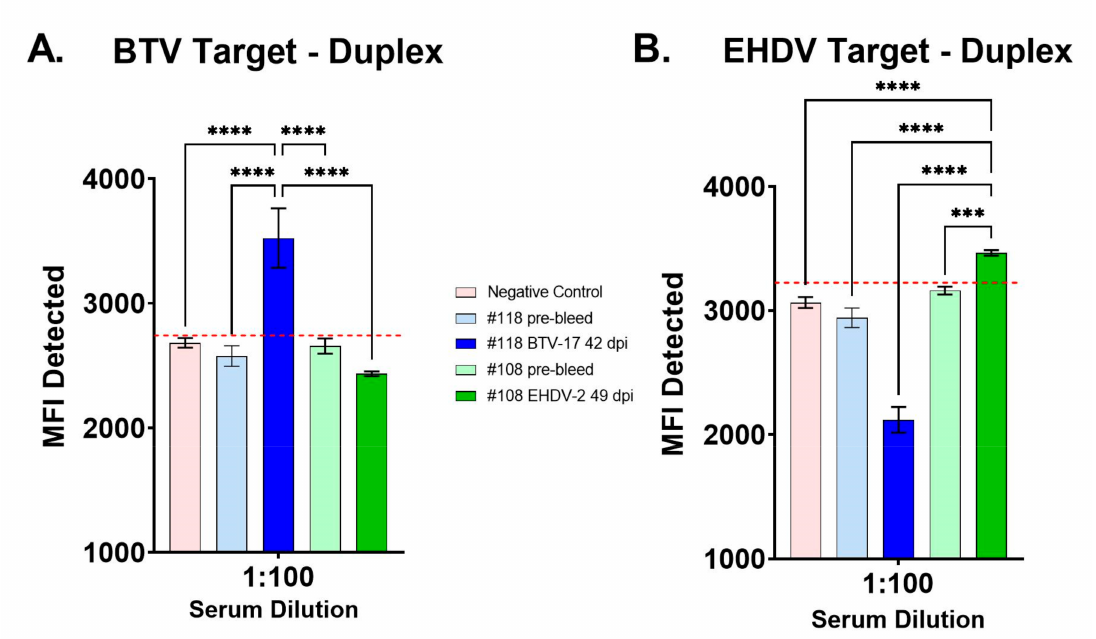
Figure 2. Mean fluorescence intensity (MFI) of the BTV/EHDV duplex FMIA for commercial negative control sera, pre-bleed sera, and post-challenge sera. ( A ) MFI results for the BTV-target microbeads with sera from a BTV-17-inoculated cow (#118) at 42 days post-infection (dpi) compared to commercial negative control sera, pre-bleed sera, and sera from an EHDV-2- inoculated cow (#108) at 49 dpi. ( B ) MFI results for the EHDV-target microbeads with sera from an EHDV-2-inoculated cow (#108) at 49 dpi compared to commercial negative control sera, pre-bleed sera, and sera from a BTV-17 -inoculated cow (#118) at 42 dpi. One-way ANOVA with Dunnett’s multiple comparisons test and standard error; *** p < 0.001, **** p < 0.0001. Receiver operating characteristic (ROC) analysis followed by a Youden’s J Index was used to inform test cutoff value (red line) within the sera tested (BTV-target = 2740.06; EHDV-target =